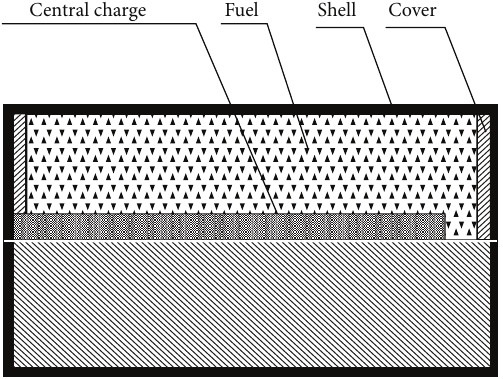
Figure 1: Sketch of charge structure (not to